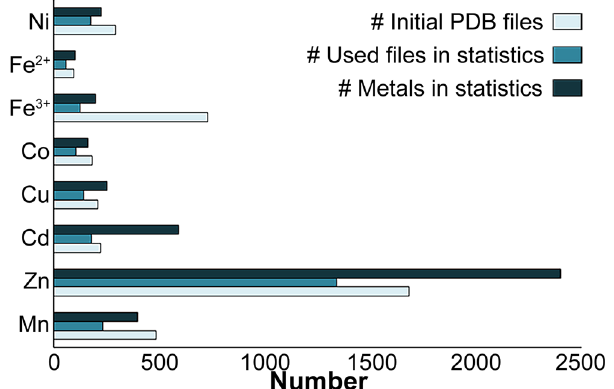
Figure 2. Number of used PDB files and metal cations in the analysis for each metal. The number of initial PDB files (light blue) refers to the number of files after primary filtration at the PDB website as described in Methods , while the numbers of used files (ocean blue) and metals (dark blue) considered in the statistical analysis refer to the final numbers after all filtration criteria were